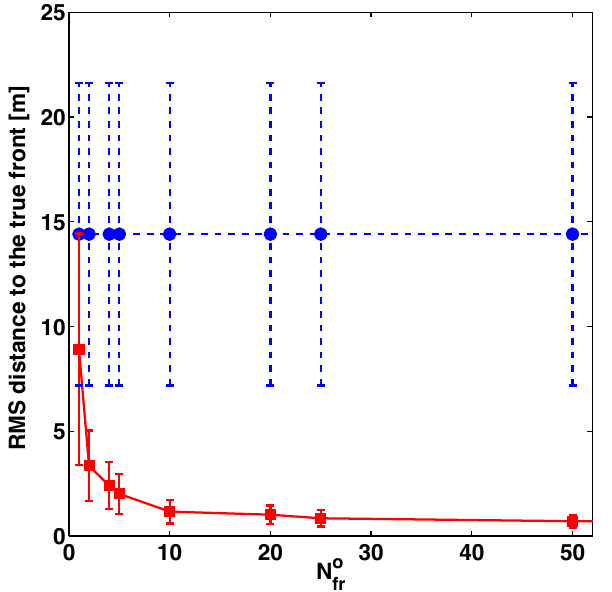
Figure 7. Average distance between the true and forecast fire front positions (blue circles) and between the true and analysis fire front positions (red squares) at time 150s as a function of the number of observed markers N os ; OSSE anisotropic case. Error bars indicate fr the associated STD.